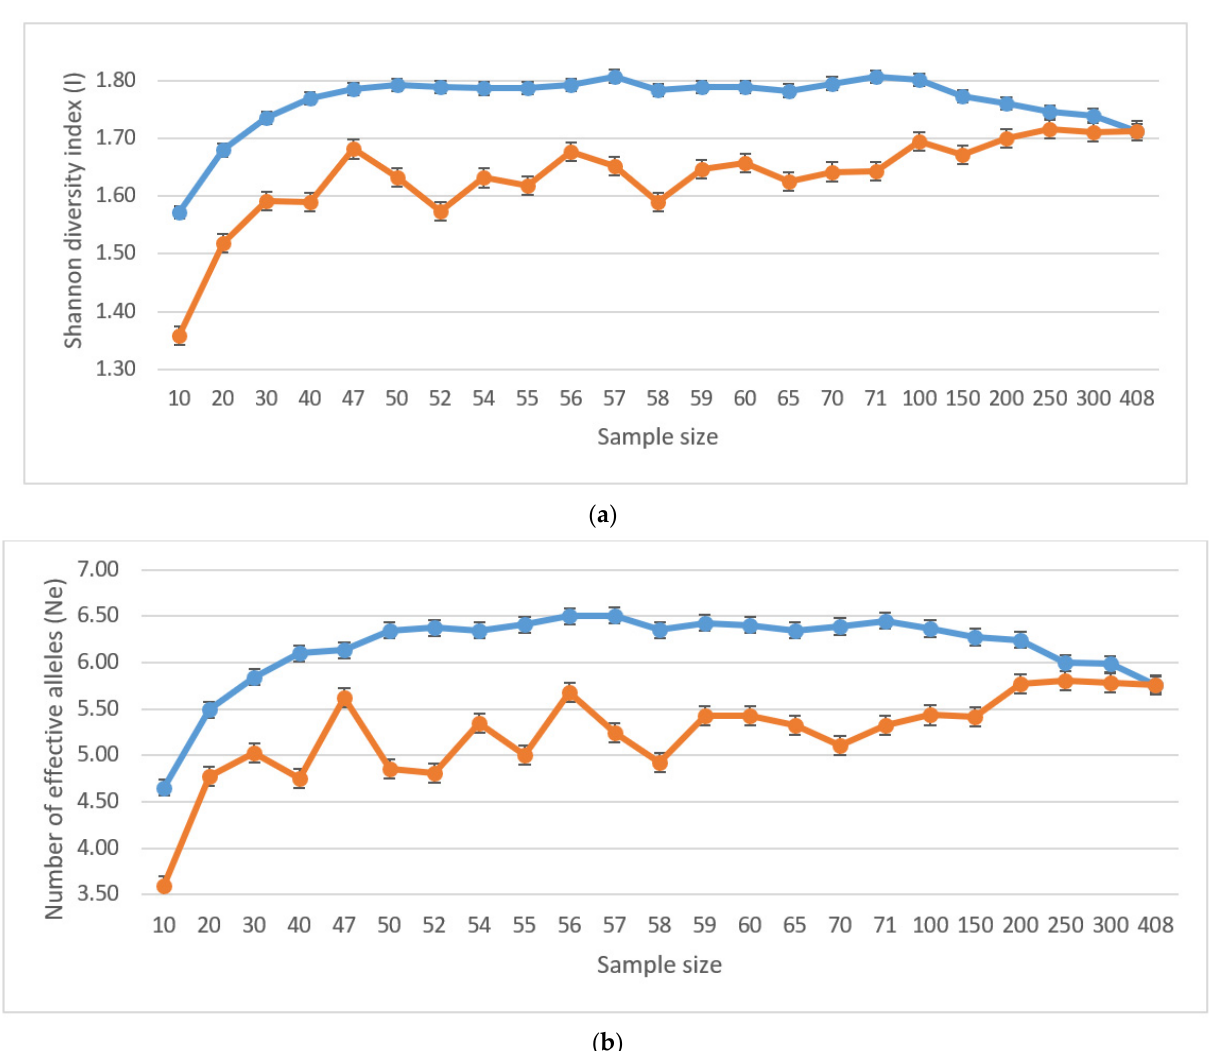
Figure 1. ( a ). Shannon diversity index (I) for various core collection sample sizes under random selection (red line), and Core Hunter entry-to-nearest-entry distance (EN) optimization objective (blue line). ( b ). Number of effective alleles (N e ) for various core collection sample sizes under random selection (red line), and Core Hunter entry-to-nearest-entry distance (EN) optimization objective (blue line).